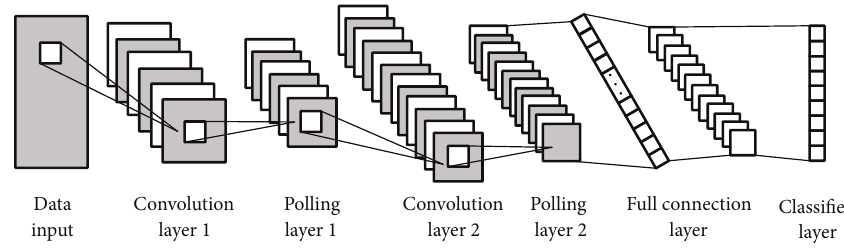
Figure 2: The basic structure of CNN.